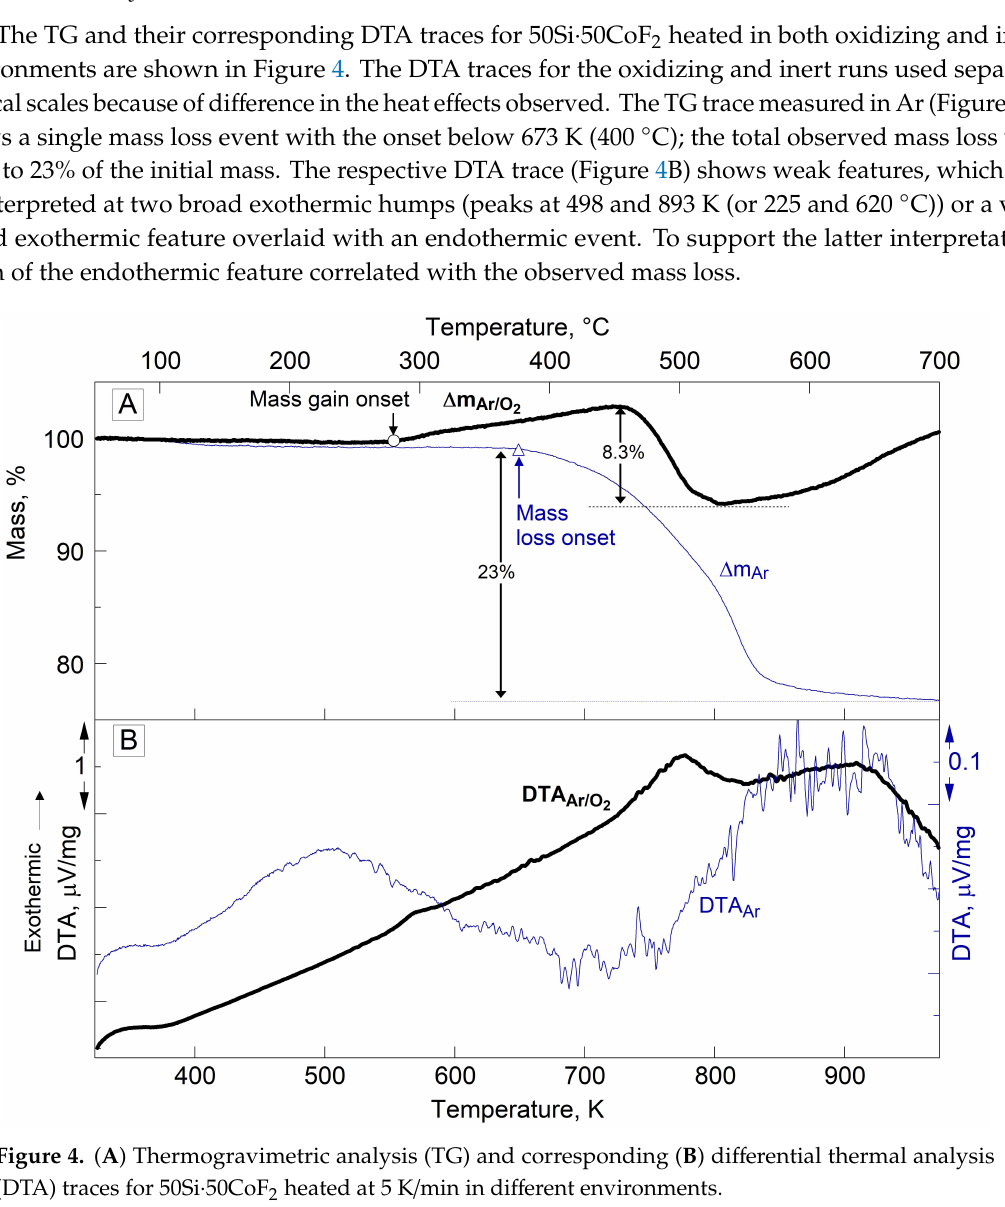
◦ C). The mass gain was ◦